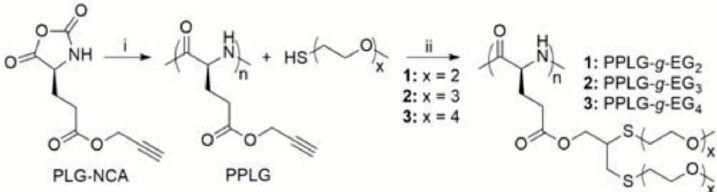
Figure 47. The synthetic route to PPLG- g -EGx by a combination of ROP of PLG-NCA and thiol-yne photochemistry. Reagents and conditions: (i) HMDS, THF/DMF 1:1 v / v , rt, 48 h. (ii) DMPA, DMF, h ν , 3 h. Reproduced with permission from reference [215].